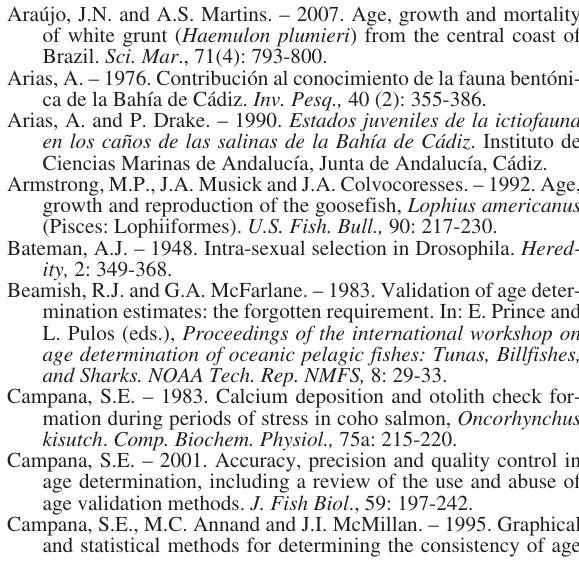
for some batrachoid species.